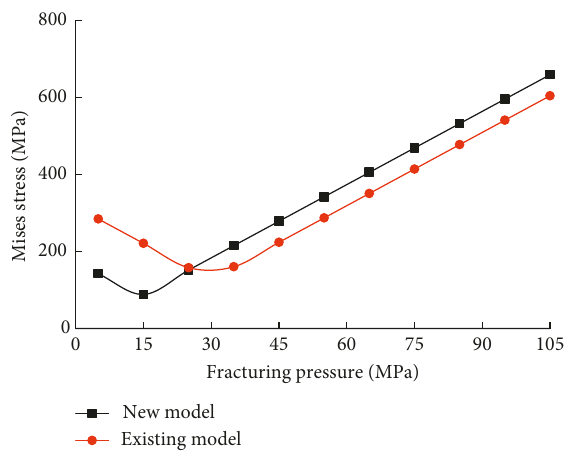
Figure 19: Maximum casing Mises stress for different pressures.